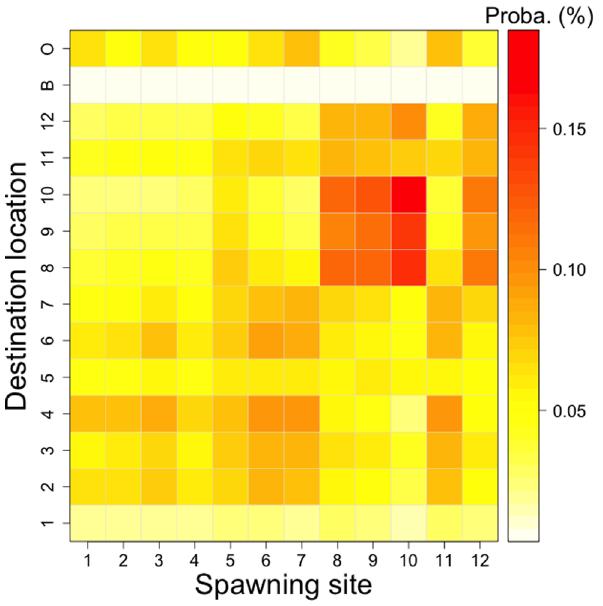
Figure 5. Potential connectivity matrix ( i.e. , probability). This potential connectivity is an average of the 12 wind regimes scenarios. The potential connectivity is calculated as the ratio between the number of larvae in the destination location j after 20 days of dispersal, coming from the spawning site i , and the total number of larvae emitted in the spawning site i . In the destination locations, ‘‘B’’ represents the shallow waters and ‘‘O’’ the open ocean. doi:10.1371/journal.pone.0095050.g005 the dispersal pathways, the larvae may experience different trophic conditions leading to different growth patterns. This might reinforce the contribution of some of the spawning site locations and thus might change the connectivity patterns. Further work